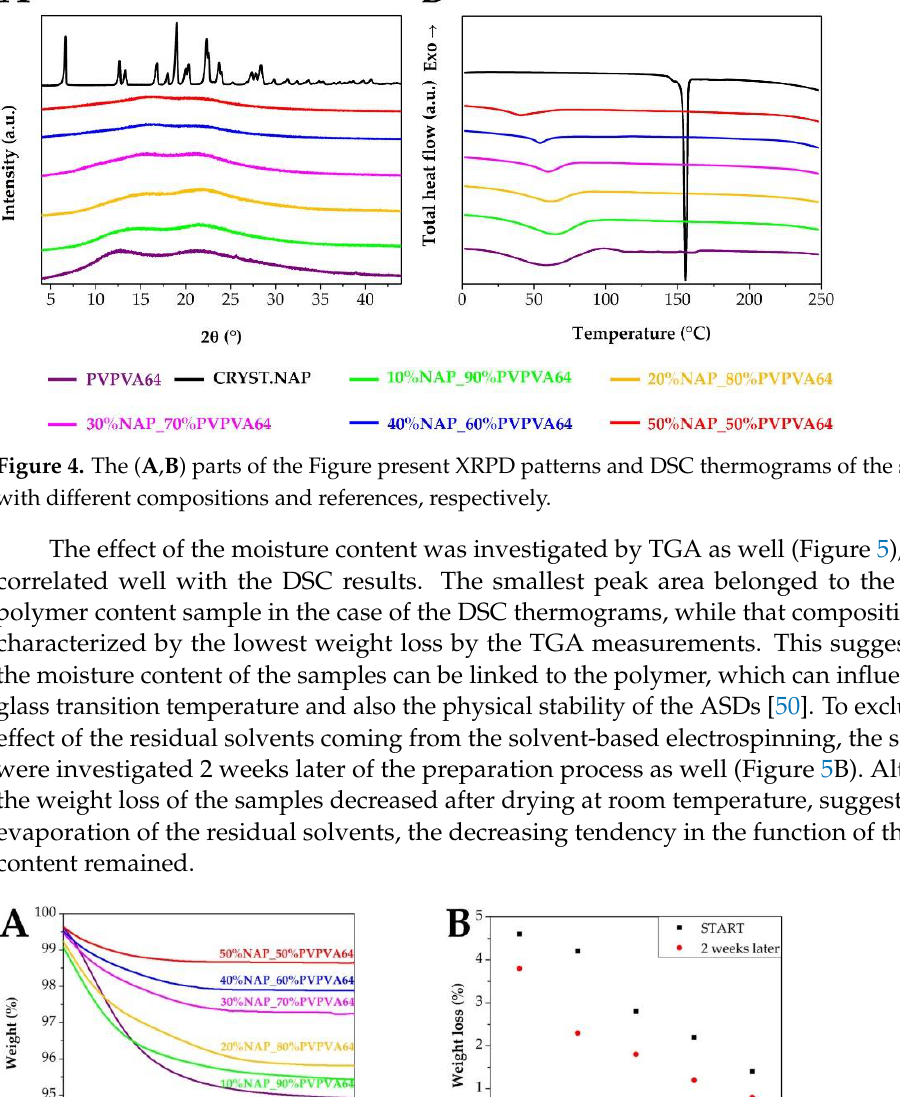
weight right after the electrospinning while ( B ) compares the weight losses of samples right after the